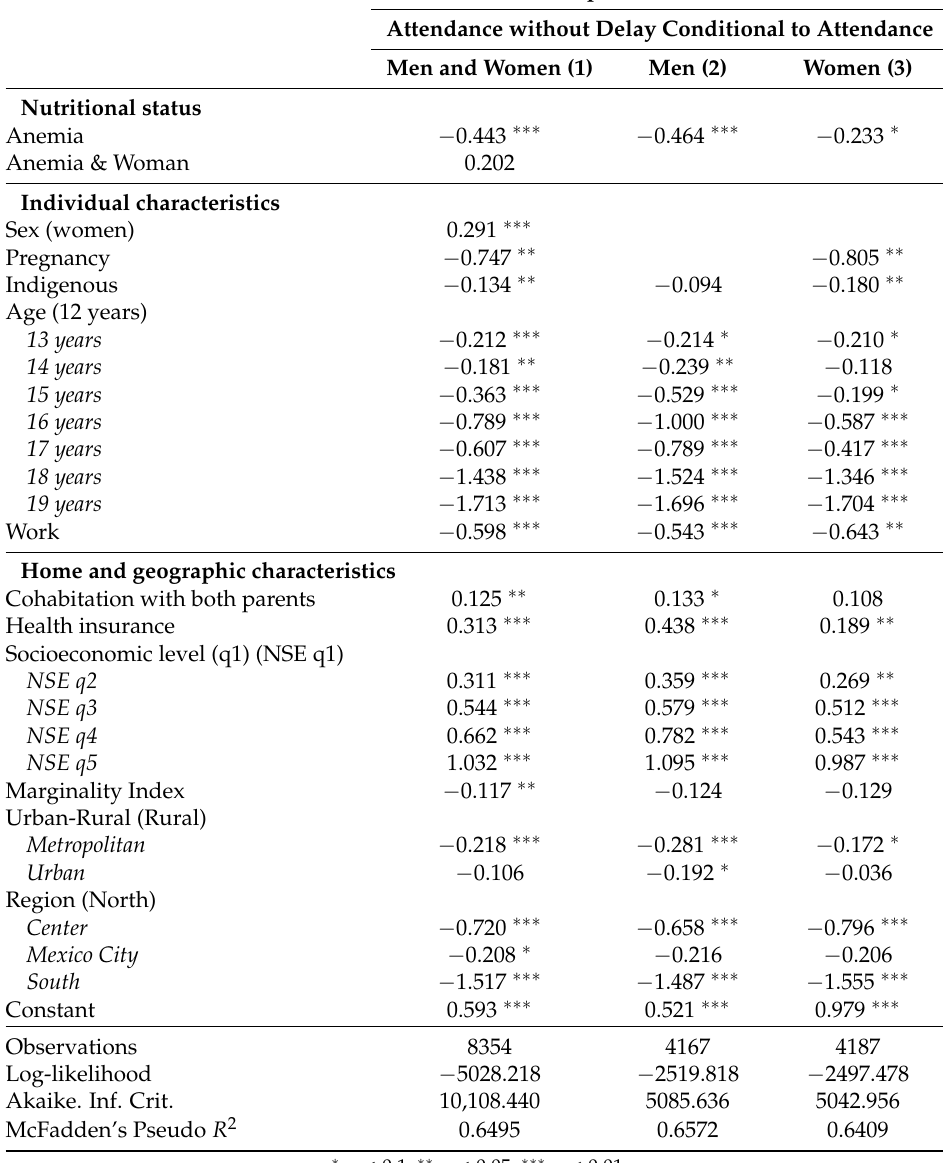
Table A3. Estimation of the marginal coefficient of the logistic regression of attendance without delay conditional on school